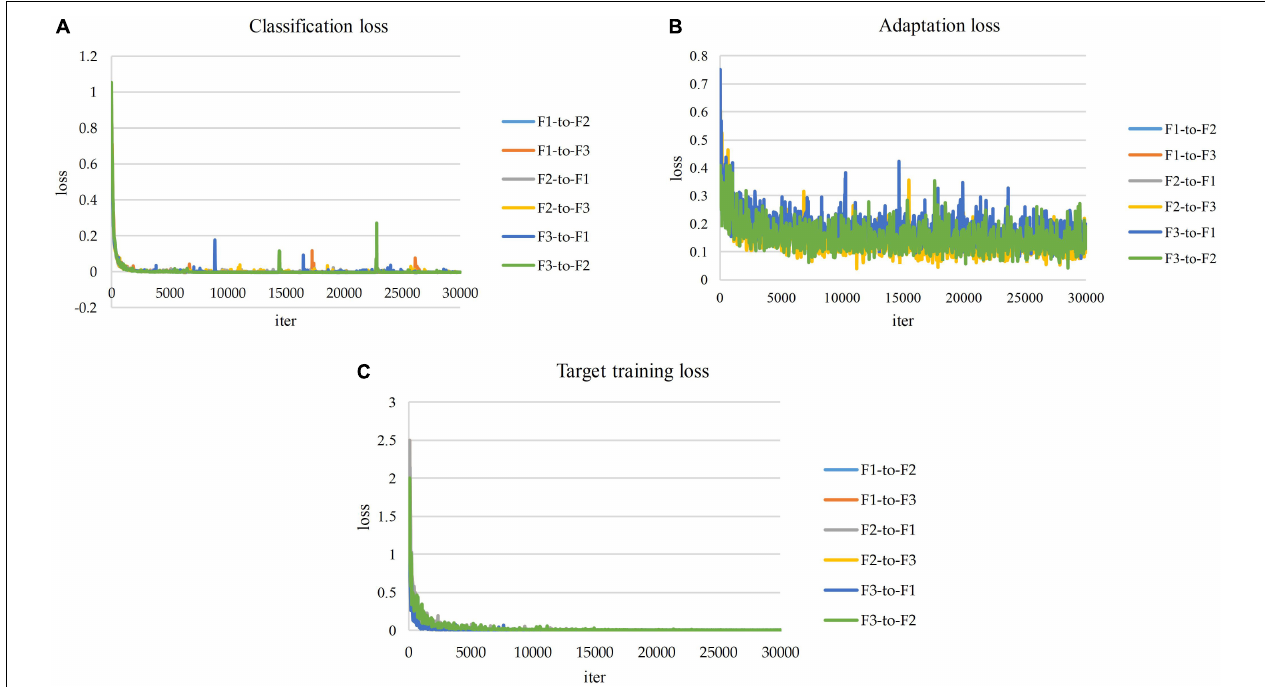
FIGURE 8 | Training losses. (A) Source training loss. (B) Adaptation loss. (C) Target training